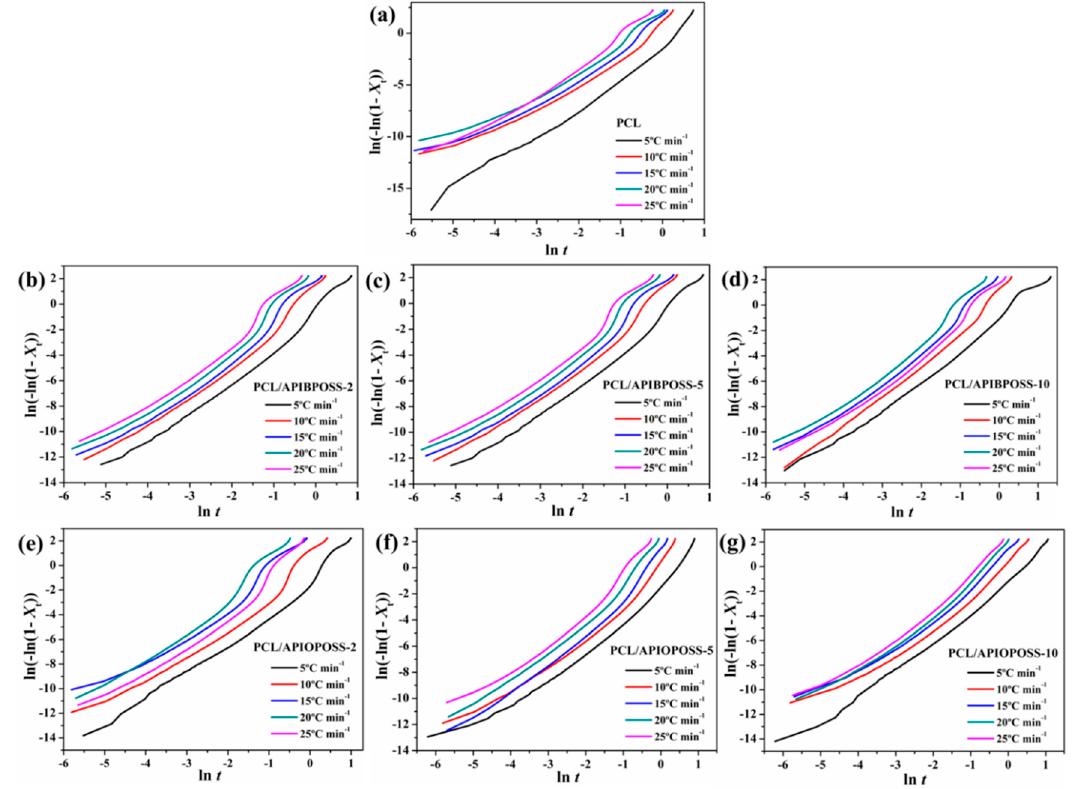
Figure 11. Avrami plots of ln[ − ln(1 − X t )] versus ln t for non ‐ isothermal crystallization of ( a ) neat PCL,